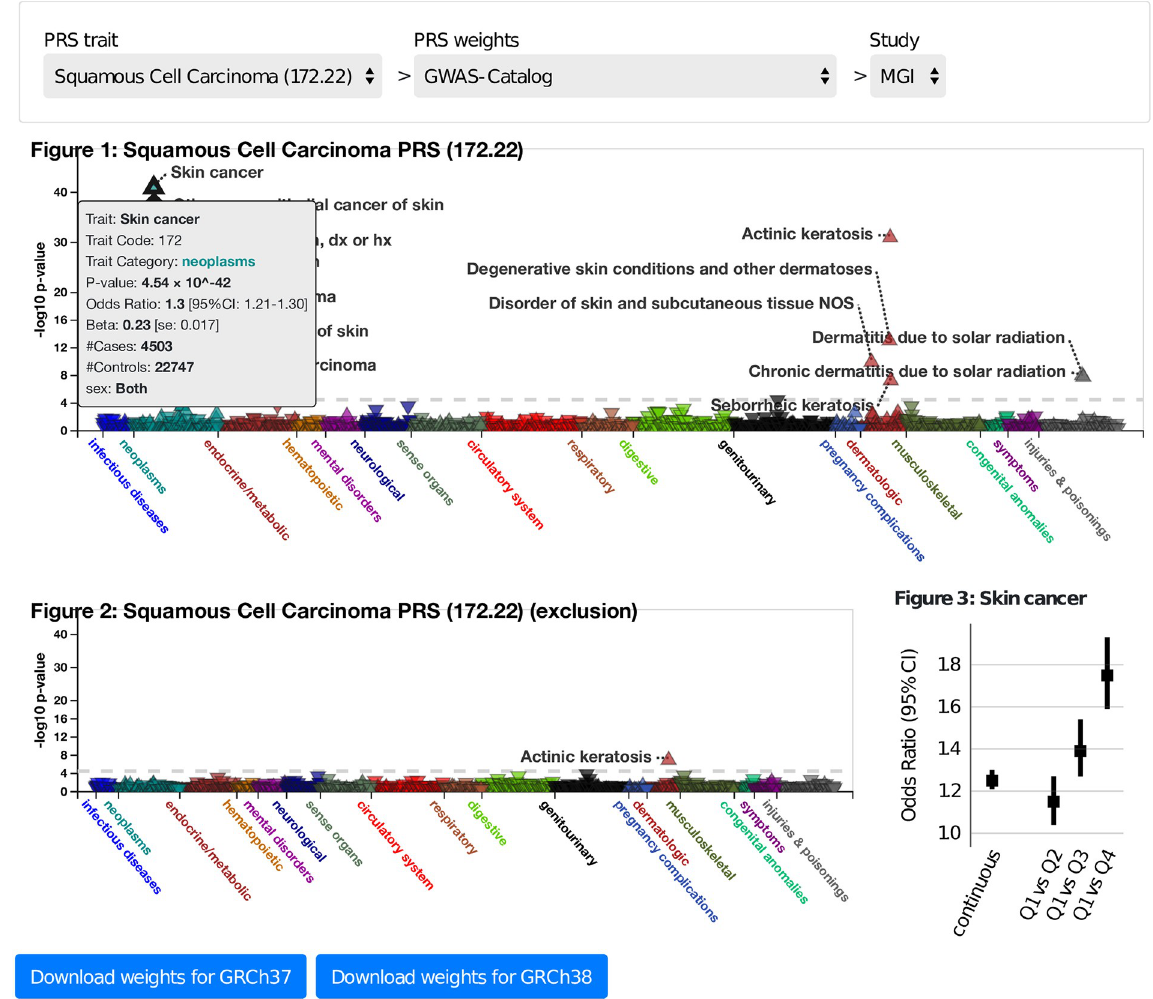
Fig 3. Example view from PRSweb (see web resources). A selection menu on top allows selection of PRS constructs and phenome while interactive plots with “PheWAS results” and “Exclusion PheWAS results” are generated after selection. “Associations between PRS and Selected Phenotype” plots are generated after clicking on a triangle in the PheWAS plots. Detailed summary statistics for each trait association are provided in mouseover elements (shown in grey). Underlying weights of a selected PRS can be downloaded via bottons below the plots